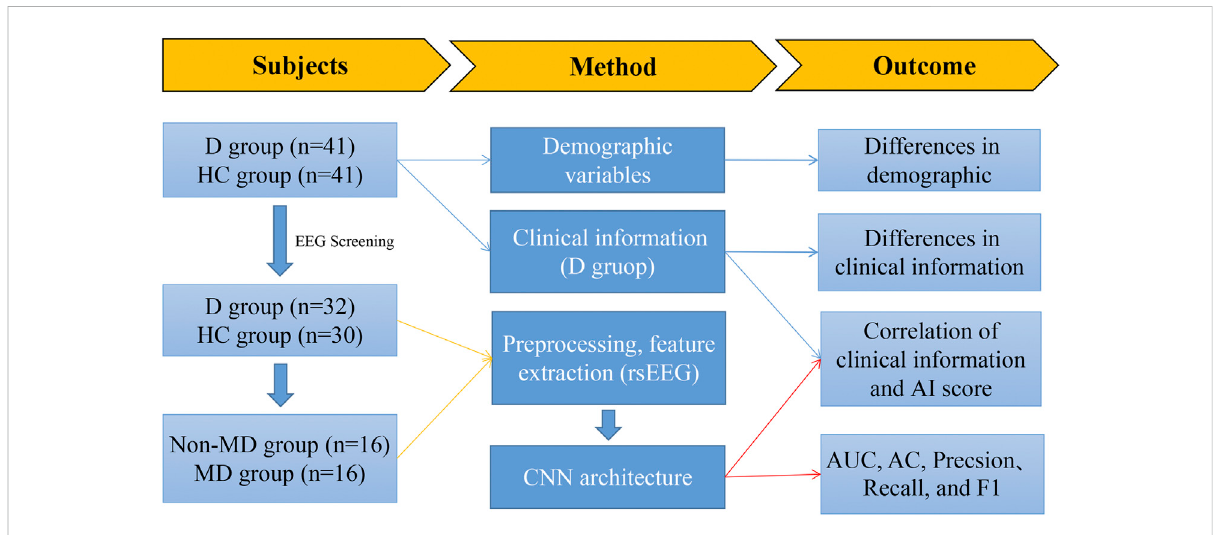
FIGURE 1 Flowchart illustrating the main content of this study. Note: D group, depression group; HC group, health control group; non-MD group, non- major depression group; MD group, major depression